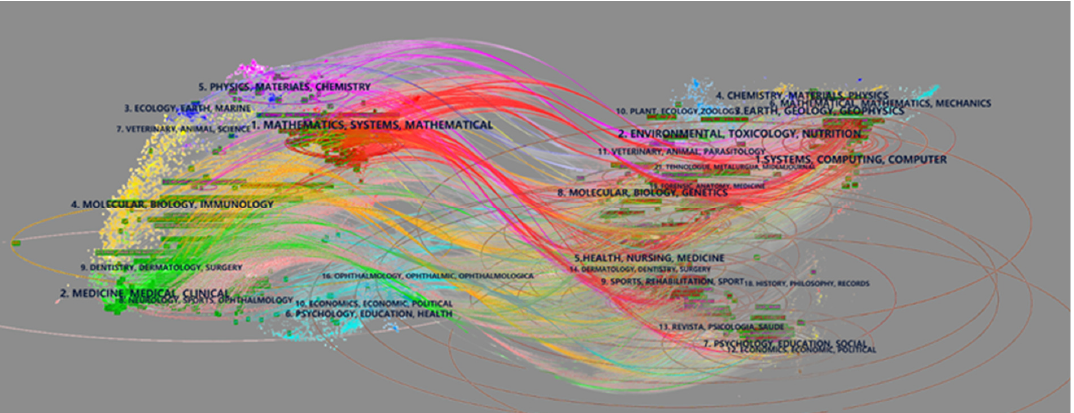
Figure 3. Journal dual-map overlays. These overlays reveal the evolution of the knowledge base through the citation structure of rehabilitation robot journals. The base map of citing journals is on the left. The base map of cited journals is on the right. Table 2. Journal co-citation analysis.